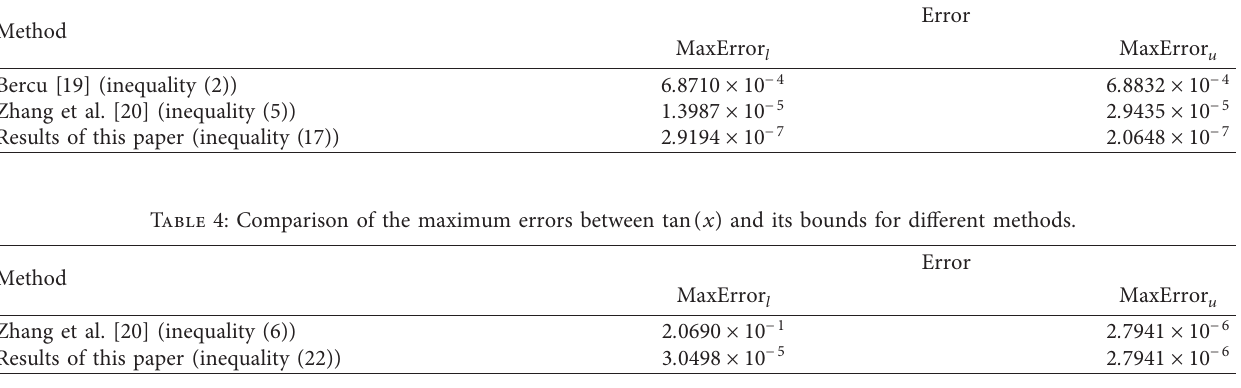
Table 3: Comparison of the maximum errors between cos ( x ) and its bounds for different methods.